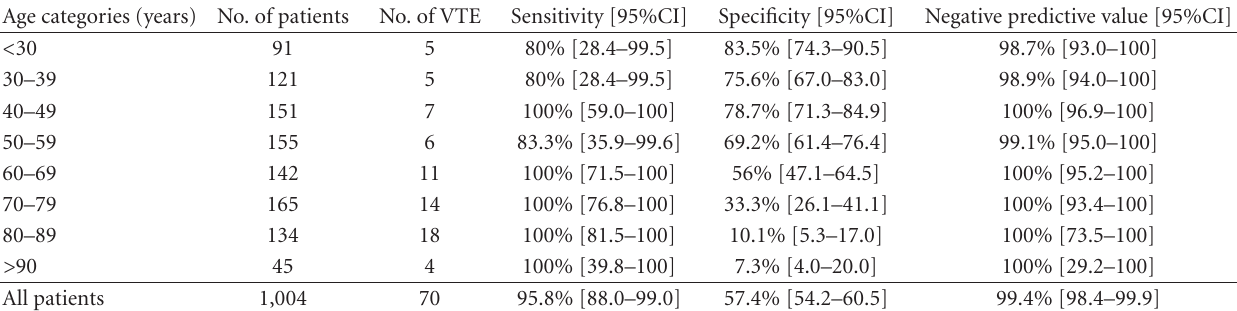
Table 1: Performance of the D-dimers “Vidas” assay according to age categories in 1,004 patients with suspected venous thromboembolic events (VTE). 95%CI: 95% confidence